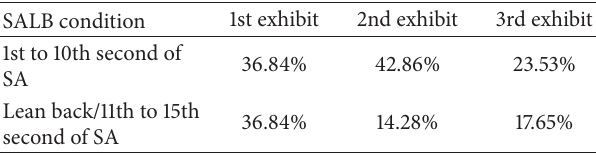
Table 1: Disengagement of the subjects from the exhibits in the SALB